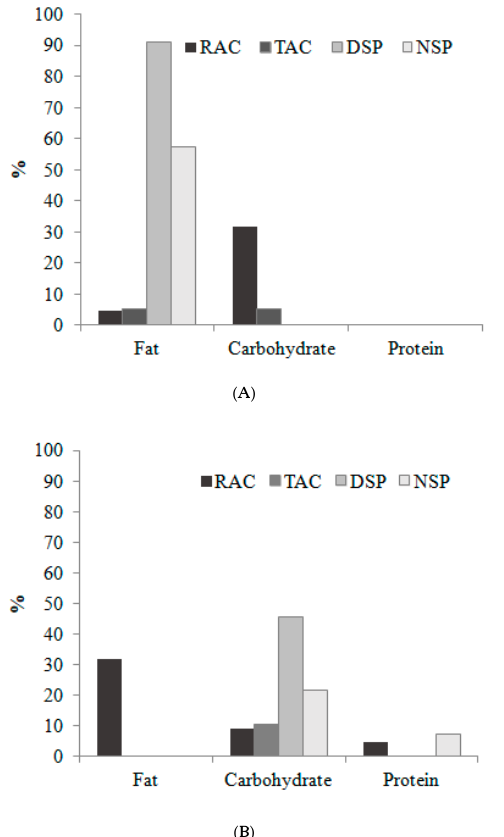
Figure 2. Macronutrient consumption among rural and urban workers in Acre (AC) and São Paulo (SP). ( Panel A ) Prevalence of excessive consumption; ( Panel B ) Prevalence of insufficient consumption. Rural = RAC, town = TAC, city-day workers = DSP and city-night workers = NSP. RAC = 22; TAC = 19; DSP = 11; and NSP = 14 workers. The acceptable macronutrient distribution range (AMDR)% energy estimates for adults; carbohydrate (45%–65%), fat (20%–35%) and protein (10%–35%). No values mean no consumption.